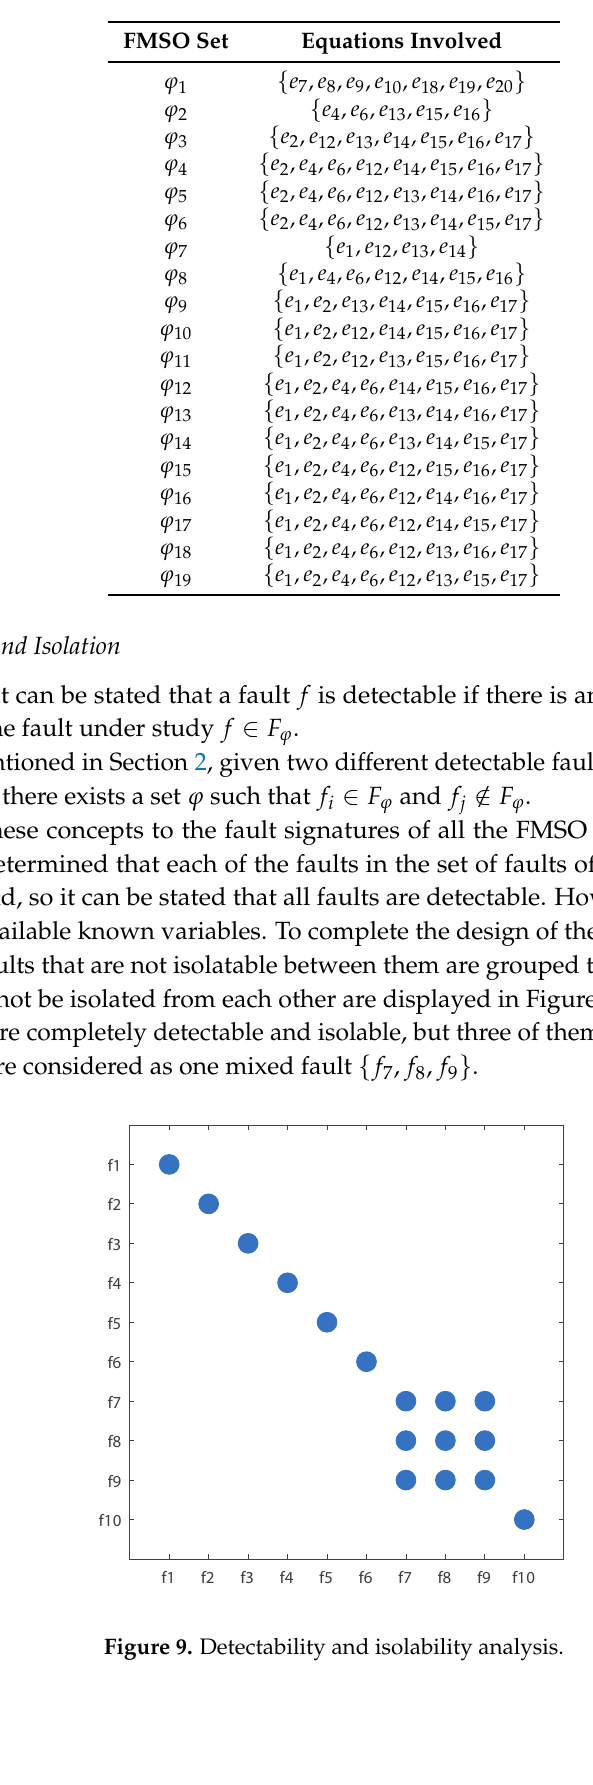
Table 1. FMSO sets found.